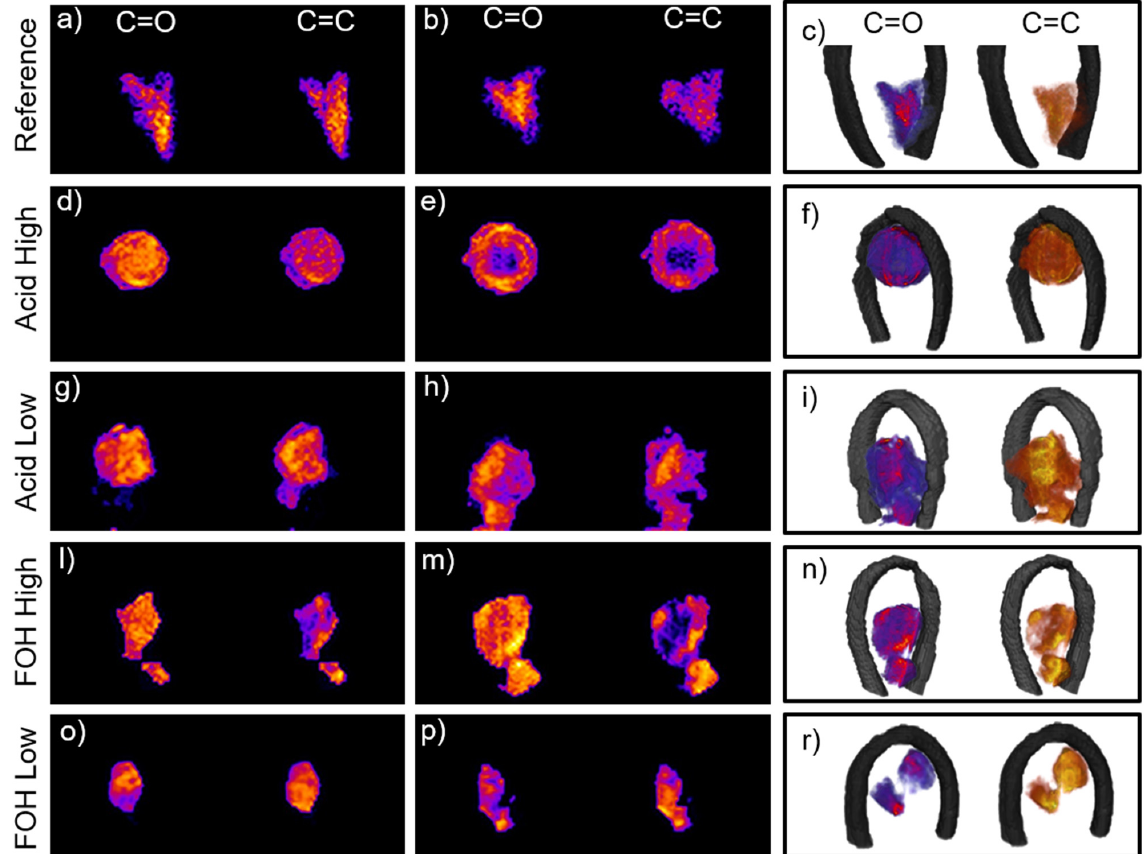
Figure 4. ( a , b ) Reference foam slices 96/150 and 68/150 from the full reconstruction in movie Reference_merged.mp4 in SI of the distribution of ROI_1 and ROI_2; ( c ) Corner-cut representation of the 3D reconstruction of the reference foam: the corner cut is generated by the intersection of two orthogonal planes in order to highlight the inner chemical distribution of the furanic areas (left in red-violet color scale) and tannin areas (right in yellow-orange color scale). From ( d – r ) same representation as ( a – c ) for Acid High (slices 50/150 and 65/150 from movie Acid_High_merged.mp4 in SI), Acid Low (slices 57/160 and 106/160 from movie Acid_Low_merged.mp4 in SI), FOH High (slices 73/100 and 55/100 from movie FOH_High_merged.mp4 in SI) and FOH low (slices 39/120 and 50/120 from movie FOH_Low_merged.mp4 in SI) formulations, respectively.